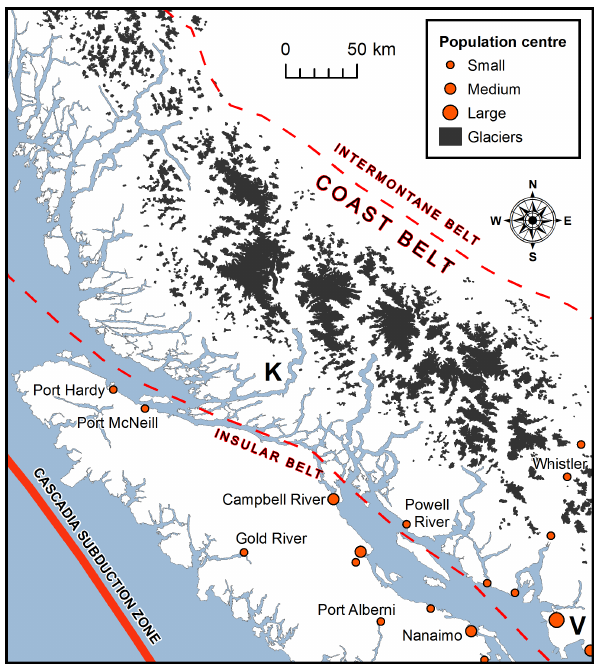
Figure 1. Location of Knight Inlet (K) on the southern British Columbia coast. Glaciers coincide with the highest parts of the Coast Mountains. V: